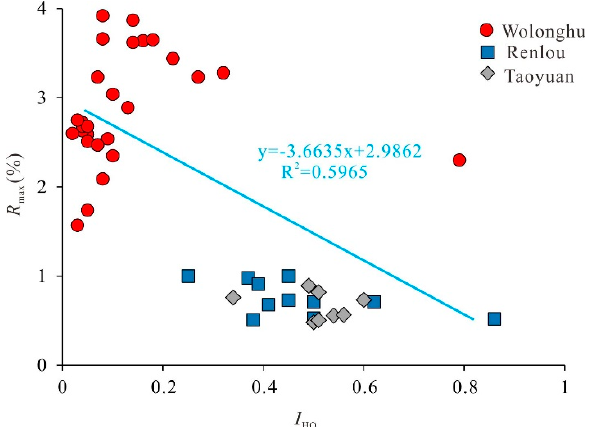
Figure 12. Correlation between I HO and R max of selected coal samples in the Huaibei Coalfield.